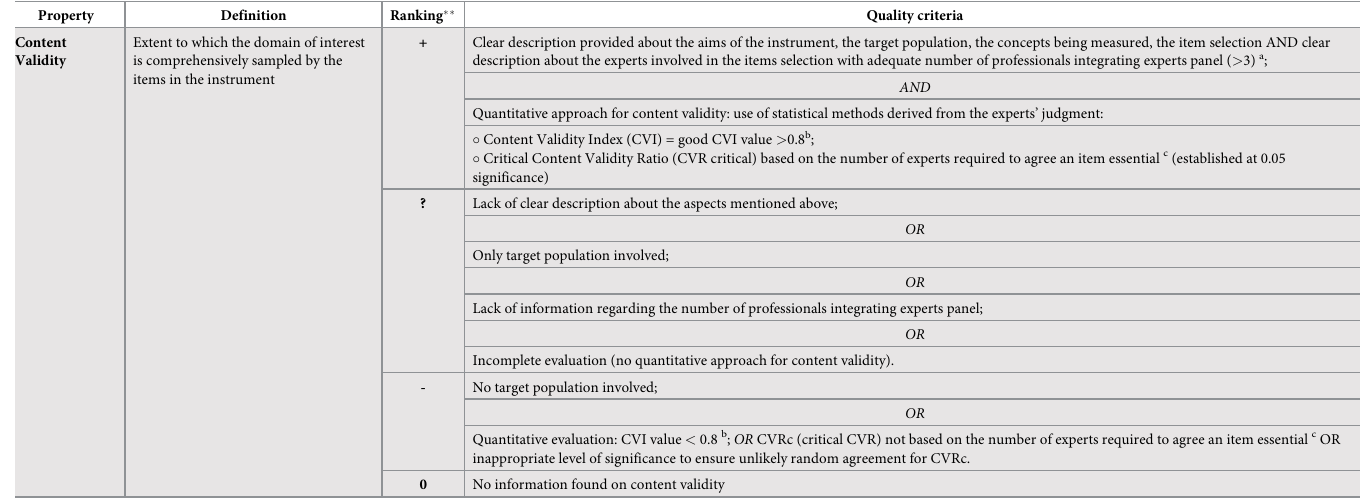
Table 1. Quality criteria for psychometric properties of measurement (adapted from Hair Jr et al . [28], Pedrosa et al . [29], and Terwee et al .